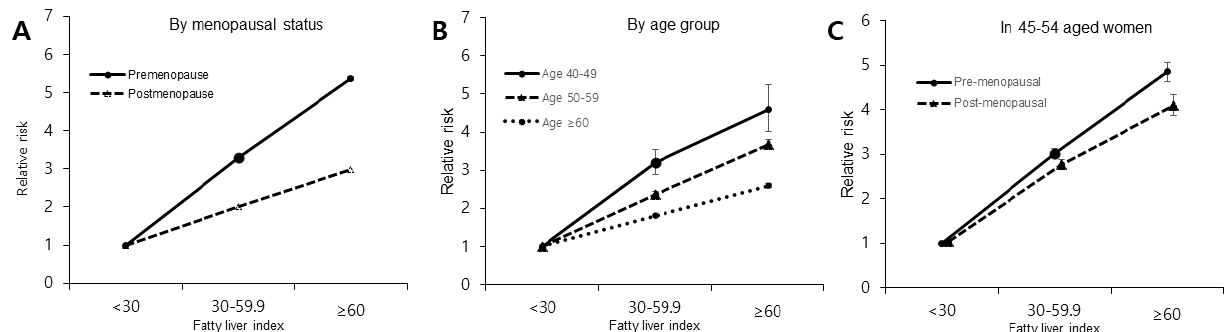
Figure 2. HR and 95% Cl of type 2 diabetes mellitus incidence according to fatty liver index. ( A ) asso- ciations between FLI and type 2 DM risk by menopausal status. ( B ) associations between FLI and type 2 DM risk by age group. ( C ) associations between FLI and type 2 DM risk by menopausal status in women between the ages of 45 and 54 years